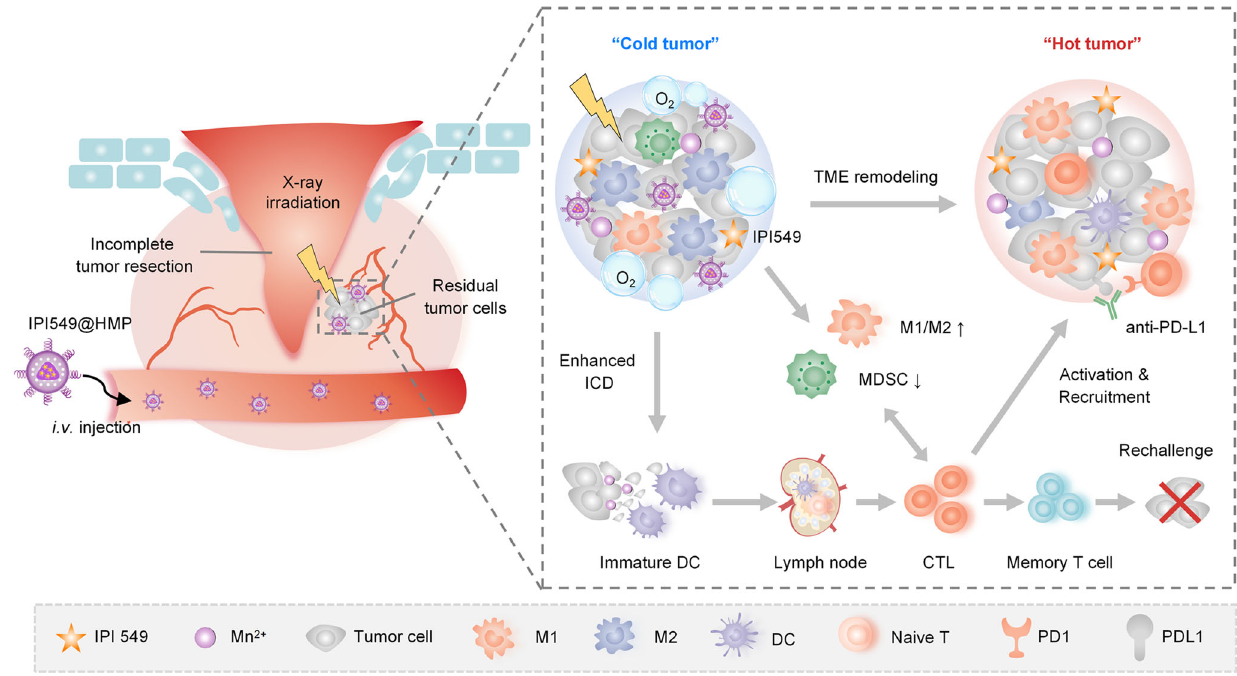
Fig. 1 Schematic illustration of engineering radioimmunostimulant nanomedicine synergizing with PD-L1 blockade for postsurgical cancer immunotherapy. Surgical resection (SR) creates an immunosuppressive milieu characterized by hypoxia and high-in fl ux of myeloid cells. The radioimmunostimulant HMnO 2 -based nanoplatform (IPI549@HMP) involved in this strategy enables hypoxia-relieved radiotherapy and pH-triggered release of IPI549 capable of targeting myeloid cells, which subsequently remodels immunosuppressive postresection TME into an immunostimulatory phenotype and heightens susceptibility to anti-PD-L1 therapy. IPI549@HMP-augmented radioimmunotherapy in combination with anti-PD-L1 leads to signi fi cant inhibition of locally residual and distant tumors, and elicits strong immune memory effect to completely resist tumor rechallenge. ICD, immunogenic cell death; M1, M1-like macrophage; M2, M2-like macrophage; MDSC, myeloid-derived suppressor cell; DC, dendritic cell; CTL, cytotoxic T